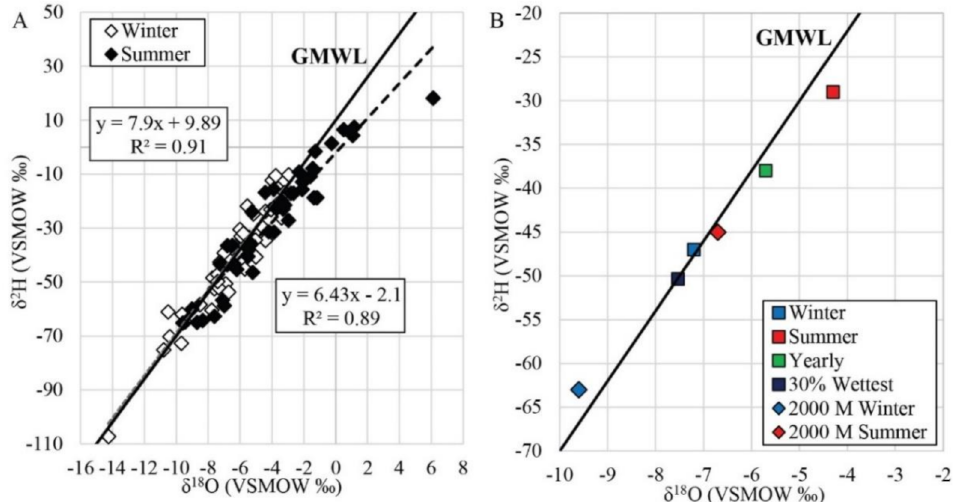
Figure 7. ( A ). δ 18 O and δ 2 H values for individual precipitation events collected within Organ Pipe Cactus National Monument between 1990 and 2016 at an elevation of ~510 masl (from [46]). ( B ). Amount-weighted mean ( δ 18 O, δ 2 H) values for winter (November to April), summer (May to October), all events (labeled “Yearly”), and the 30% most intense events (including summer and winter) from data in ( A ). “2000 M Winter” and “2000 M Summer” was calculated using the mean isotopic altitude e ff ects in Tucson, Arizona (1.6% (cid:24) per 1000 m for δ 18 O and 11% (cid:24) per 1000 m for δ 2 H) [27]